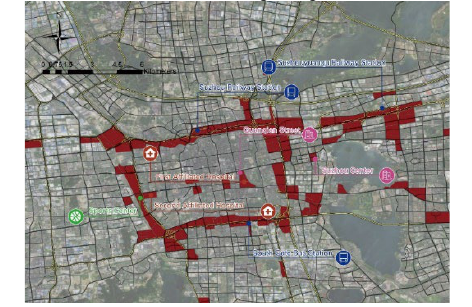
Figure 7. Zonal-based emissions per square kilometer of TAZ